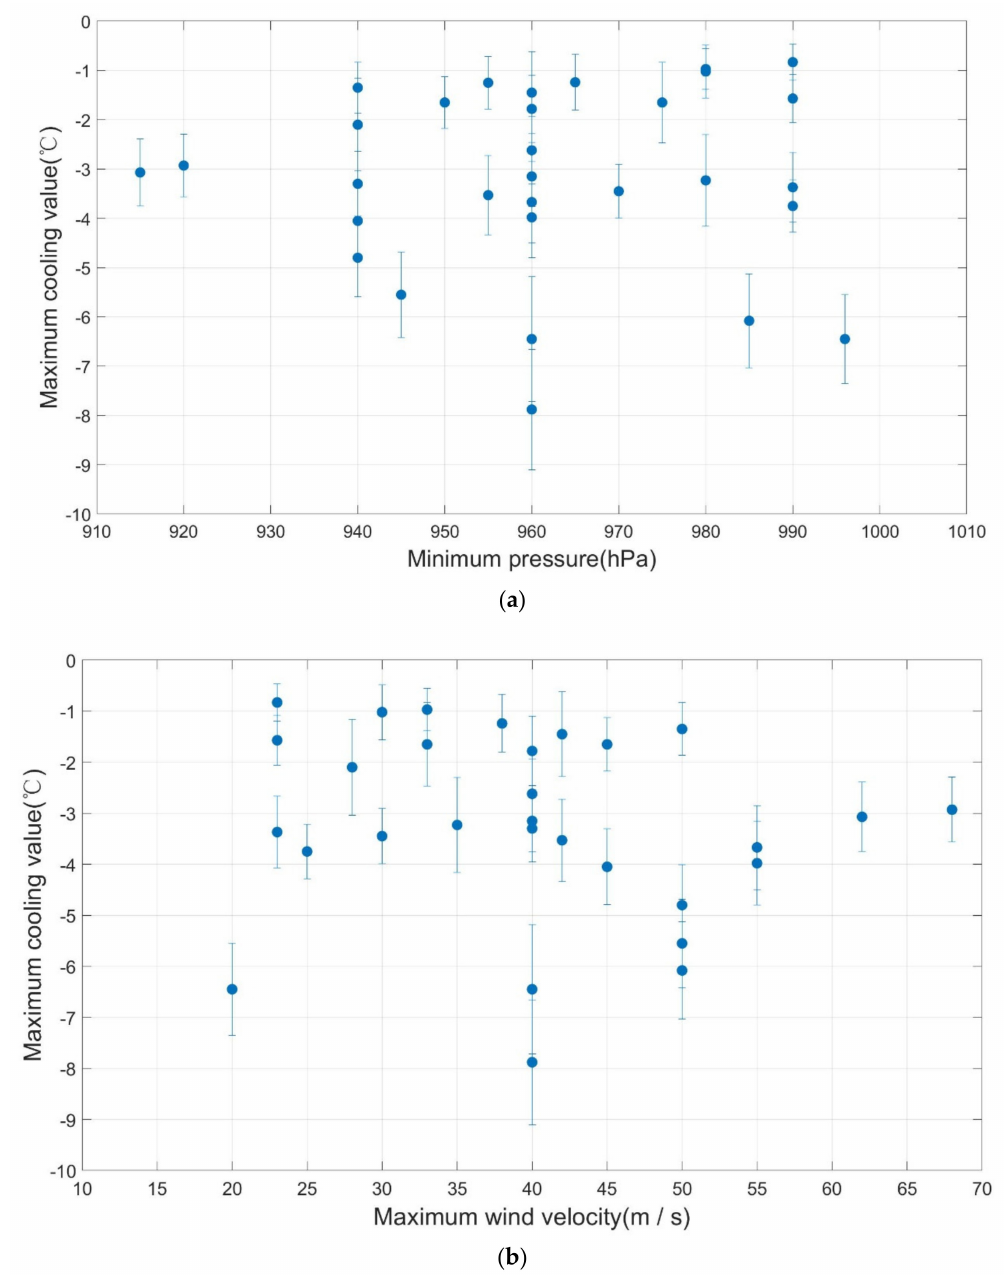
Figure 3. Correlation of maximum cooling value with low pressure center pressure and maximum wind velocity: ( a ) De- scription low pressure center; ( b ) Description maximum wind